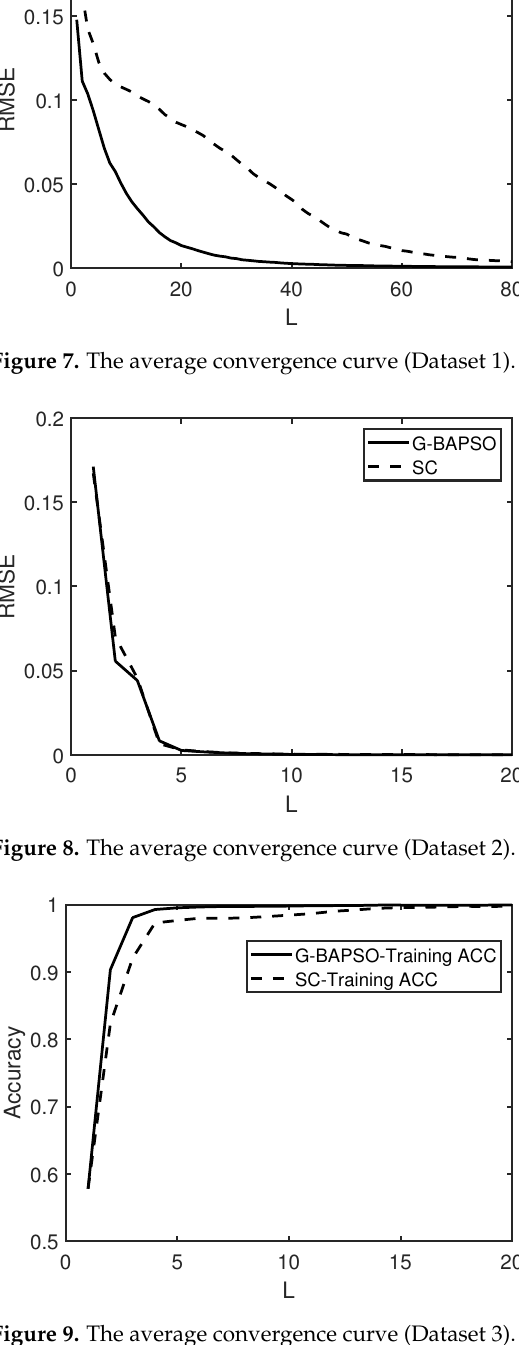
Figure 9. The average convergence curve (Dataset